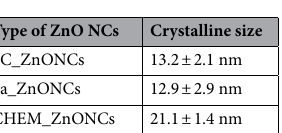
Table 1. Average crystallite size of ZnO NCs calculated from the Scherrer’s